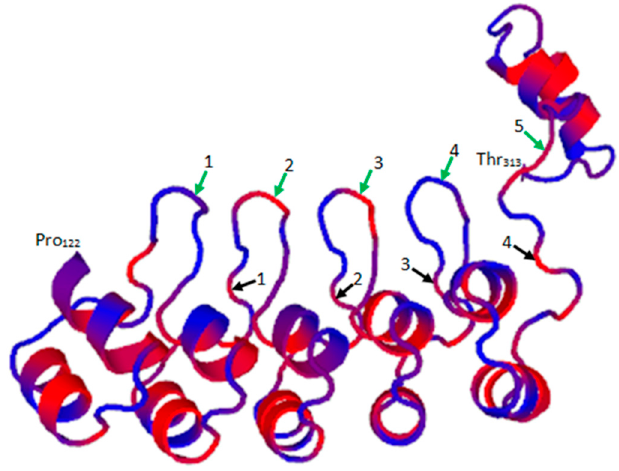
Figure 2. Predicted Swiss Model of ANKRD1. The 3D structure of ANKRD1 from Pro 122 to Thr 313 is shown (blue) with hydrophobic residues indicated in red. Ankyrin repeat units 1 (Tyr 152– Phe 181 ), 2 (Leu 185 –Ala 214 ), 3 (Leu 218 –Ala 247 ), 4 (Glu 251 –Ile 280 ) and 5 (Ala 284 –Arg 315 ) are indicated by green and black arrows showing the start and end of each unit, respectively. The end of ankyrin repeat unit 5 terminating at Arg 315 is not shown.